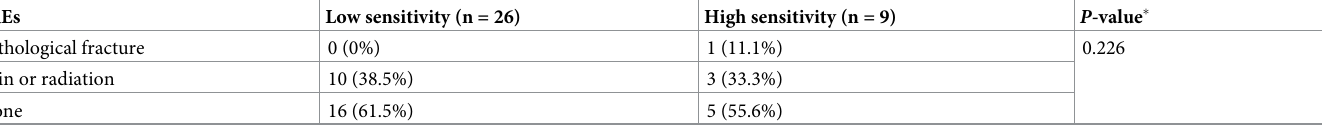
Table 8. Types of SREs and sensitivity to alcohol.